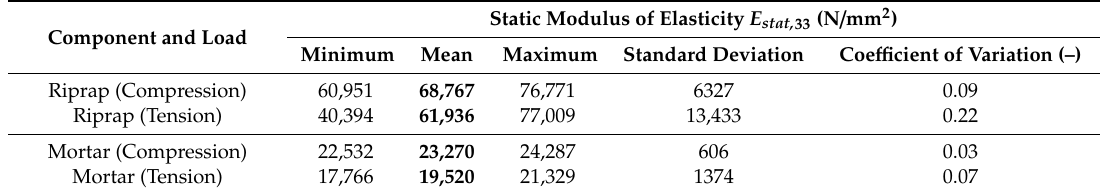
Table 3. Static modulus of elasticity E stat, 33 of the components of MGRRs, dependent on the load (after [31]).